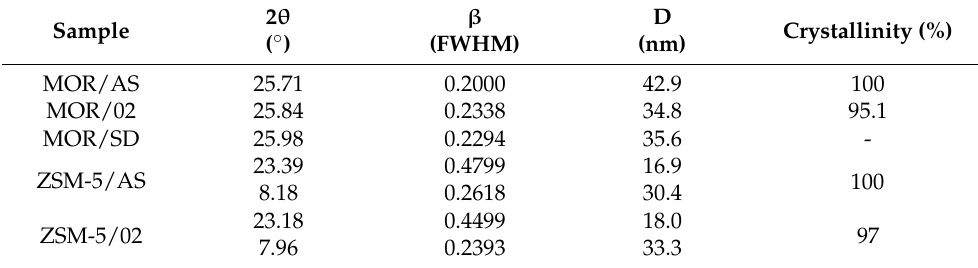
Table 2. Size of the crystallite (D) calculated by the Scherrer